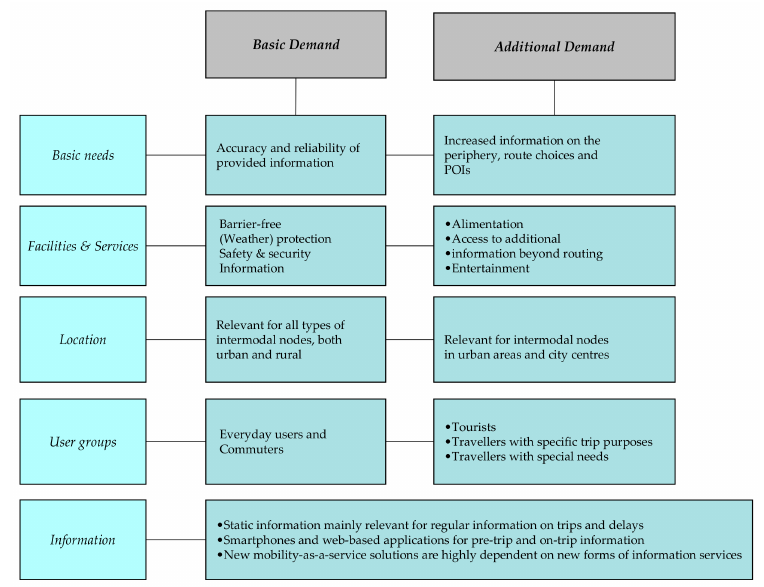
Figure 1. User requirements at public transport